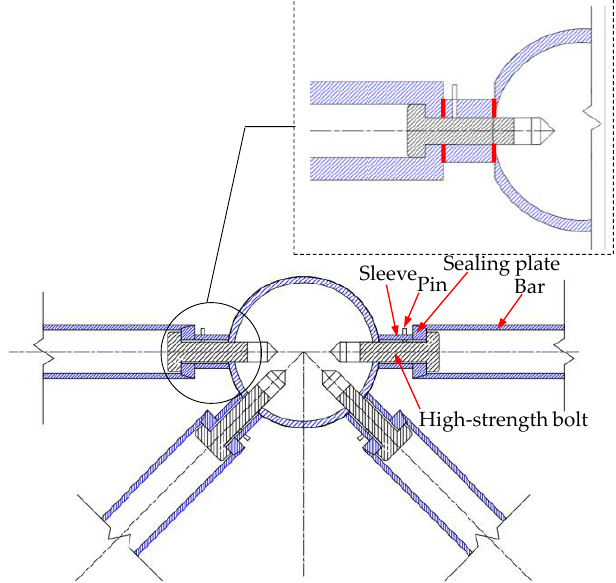
Figure 2. Cross section of bolted spherical joint connection.